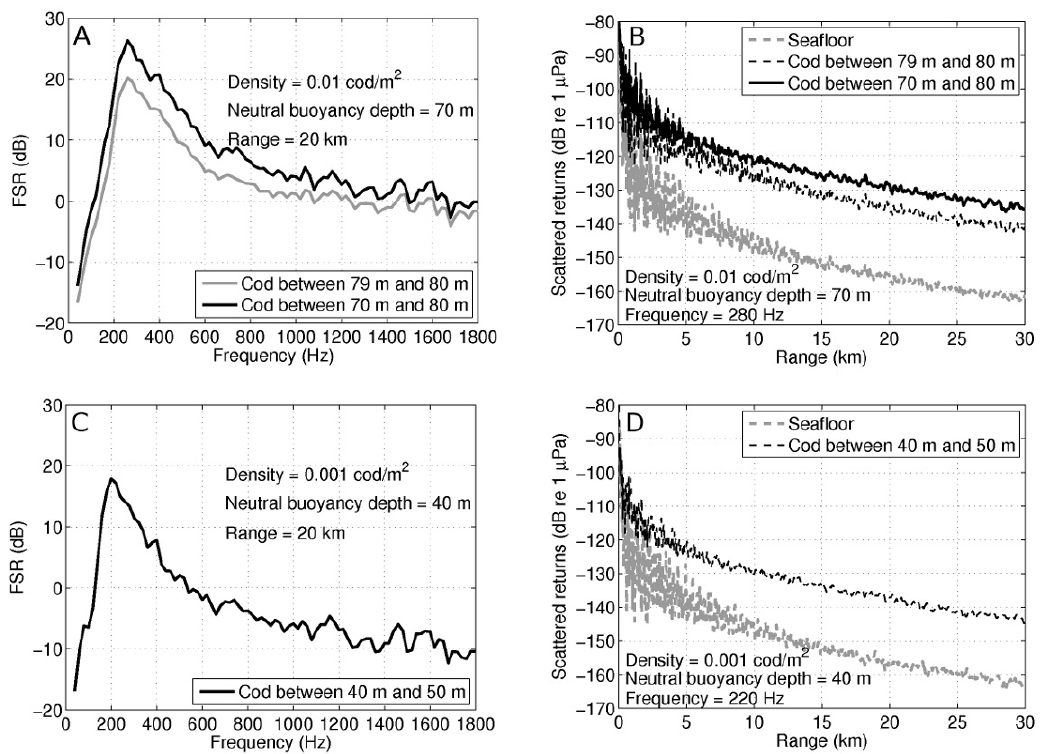
Figure 4. The Ocean Acoustic Waveguide Remote Sensing (OAWRS) fish-to-seafloor scattering ratio (FSR) (Equation (5)) as a function of frequency and the normalized scattered returns from cod vs . seafloor for various cod configurations in the water column of a depth of 80 m. The minimum population density required for OAWRS detection of cod at or near the swim bladder resonance is roughly 1 × 10 − 4 cod/m 2 for bottom-dwelling cod and roughly 1 × 10 − 5 cod/m 2 for mid-water column cod. Cod are assumed to be neutrally buoyant at the shallowest limit of their assumed occupancy depth range in each case. The aggregation density in ( A )–( B ) is 0.01 cod/m 2 , similar to that observed during spawning in Ipswich Bay [32,33], and in ( C )–( D ) is 0.001 cod/m 2 , similar to that observed during feeding [40,41]. The cod body length is assumed to follow the distribution measured during a recent Ipswich Bay spring survey in 2011, as shown in Figure 2. Methods for the estimation of FSR and the scattered returns are described in Sections 3.2 and